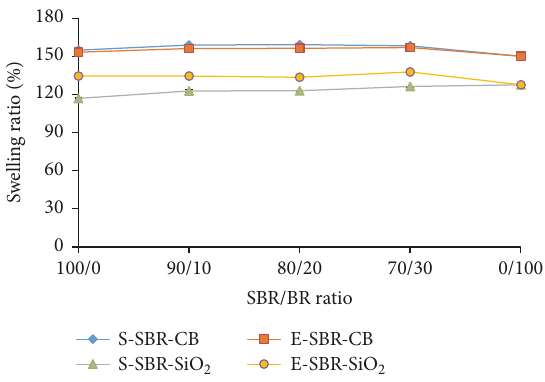
Figure 4: Payne effect of the rubber compounds. Figure 5: Dependence of swelling ratio on SBR/BR blend ratio.